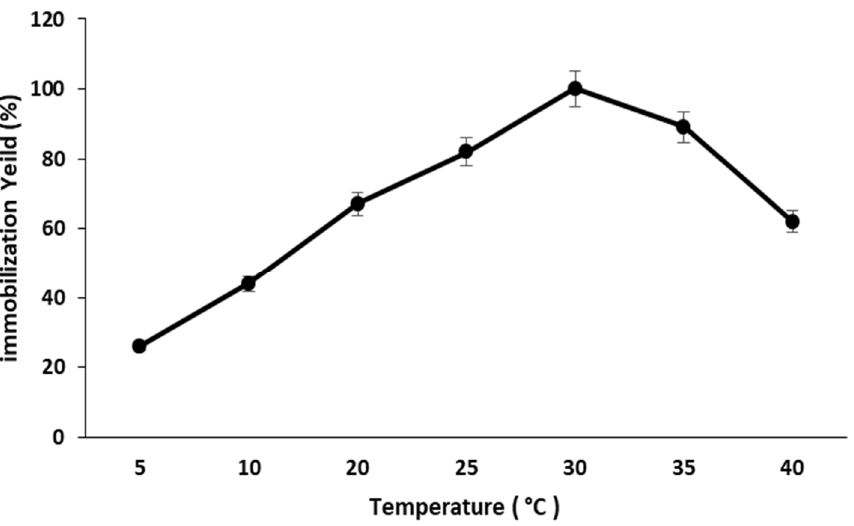
Figure 5. Effect of temperature on the immobilization of pectinase on magnetic iron oxide